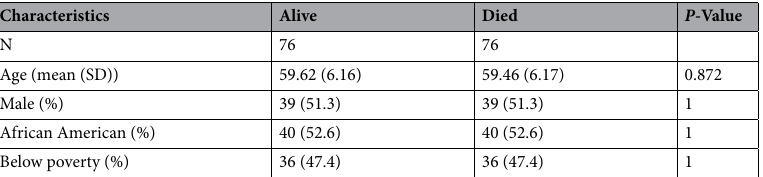
Table 1. Demographics for EV and mortality sub-cohort of the HANDLS study. Pearson’s chi-squared tests were used to analyze differences for sex, race and poverty status. Student’s t-test was used to analyze differences among the groups for age. SD = standard